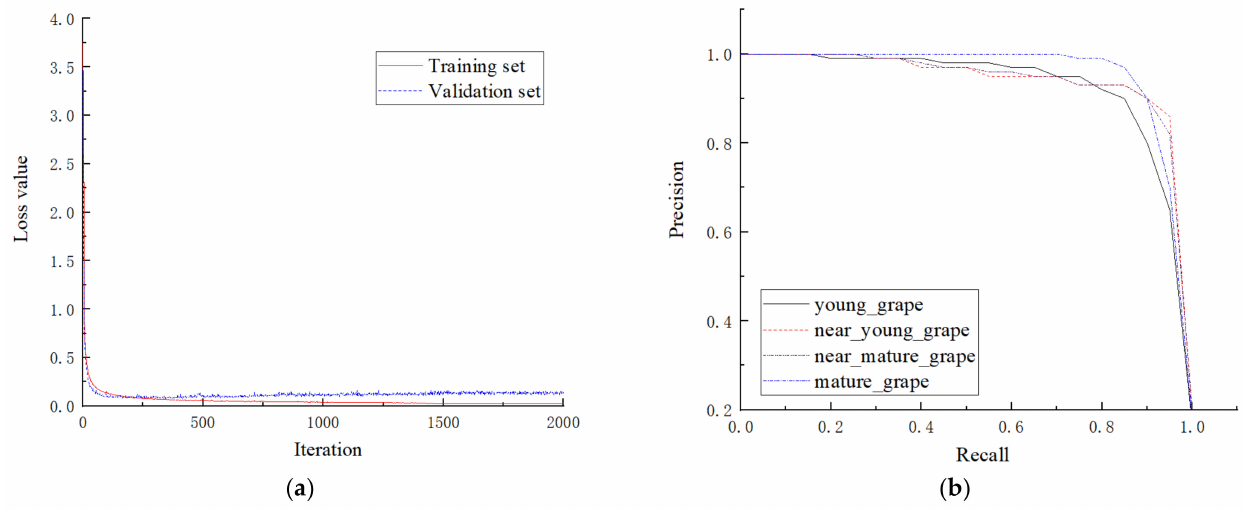
Figure 8. Loss curves and the Precision–Recall curves. ( a ) Loss curve. ( b ) Precision–Recall curve.